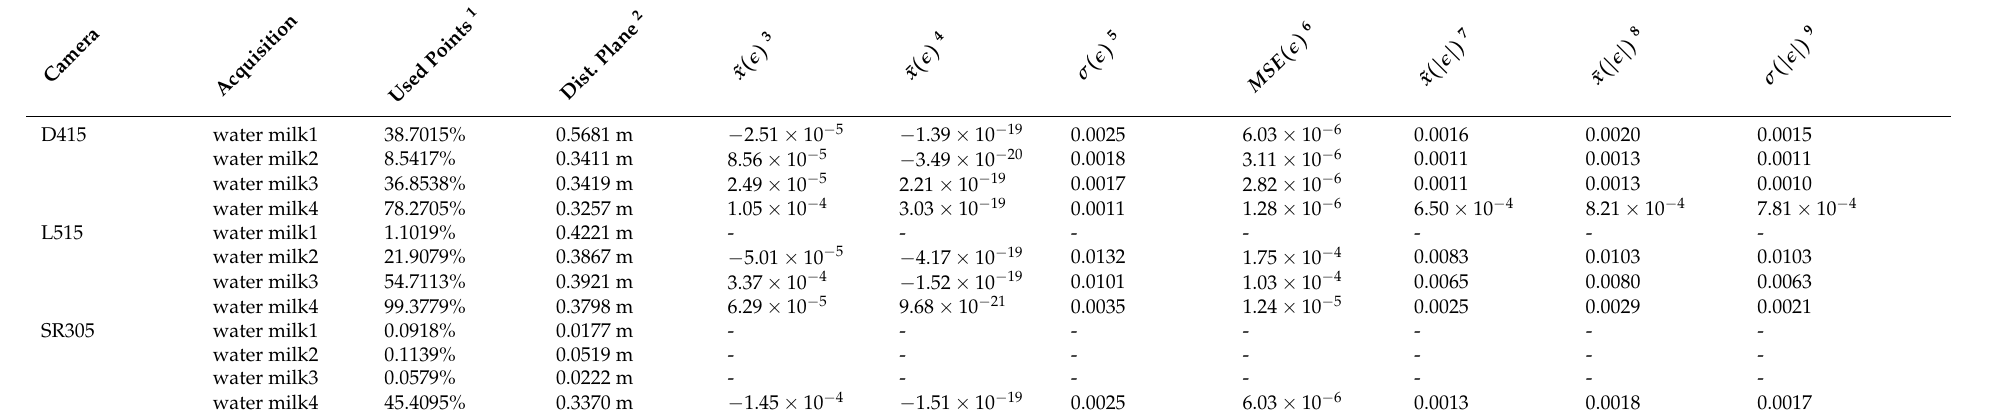
Table 5. Results for orthogonal distances to planes for the experiments water milk1 , water milk2 , water milk3 and water milk4